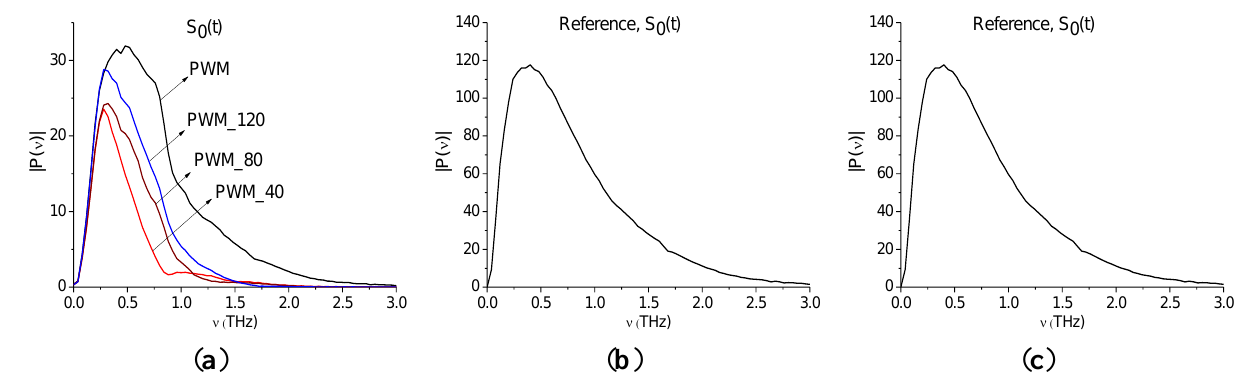
Figure 14. Fourier spectra ( a ) and reflectance ( b ) of the main pulses S 0 ( t ) of the PWM_40, PWM_80, PWM_120 and PWM signals; Fourier spectrum of Reference signal ( c ).